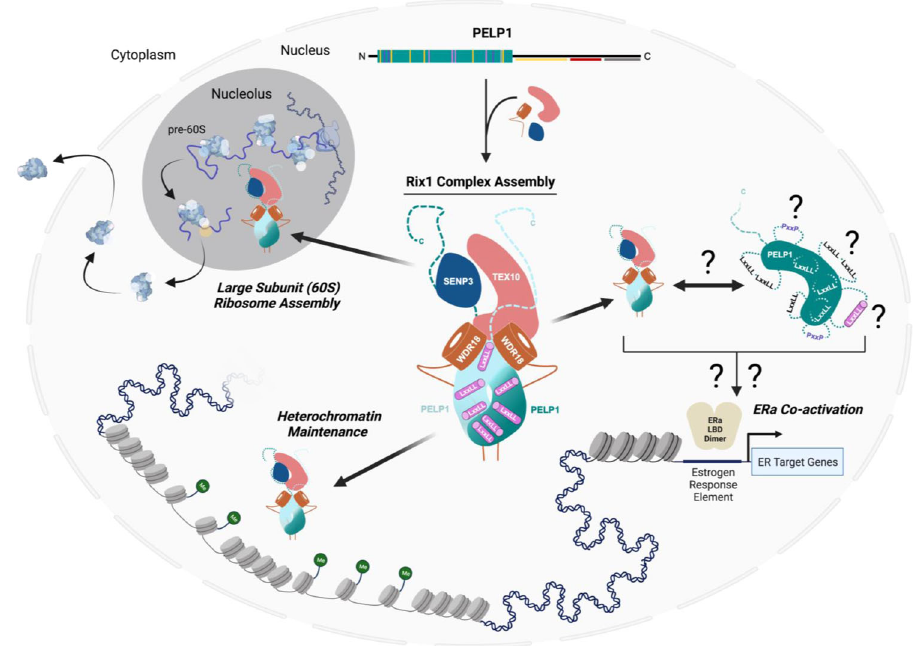
Fig.7|ThevariousbiologicalfunctionsofthehumanRix1scaffoldingcomplex. ThehumanRix1scaffoldingcomplexisimplicatedinvariousbiologicalfunctionsin the cell nucleus including large subunit (60S) ribosome assembly, hetero- chromatin maintenance, and steroid receptor coactivation of transcription. PELP1 is the central scaffold of the Rix1 complex and is likely primarily associated with, and functions within, this complex in the nucleus during its roles in ribosome assembly and heterochromatin maintenance. PELP1 facilitation/in fl uence on ER α